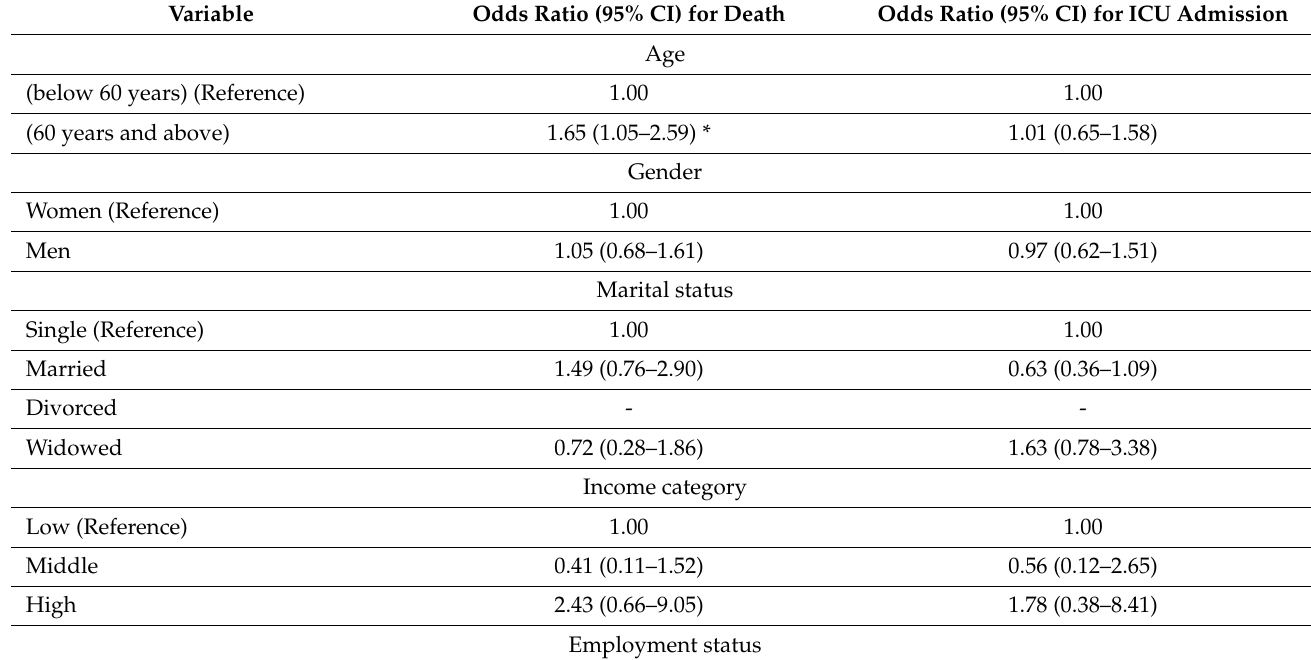
Table 3. Risk factors associated with cancer death and ICU